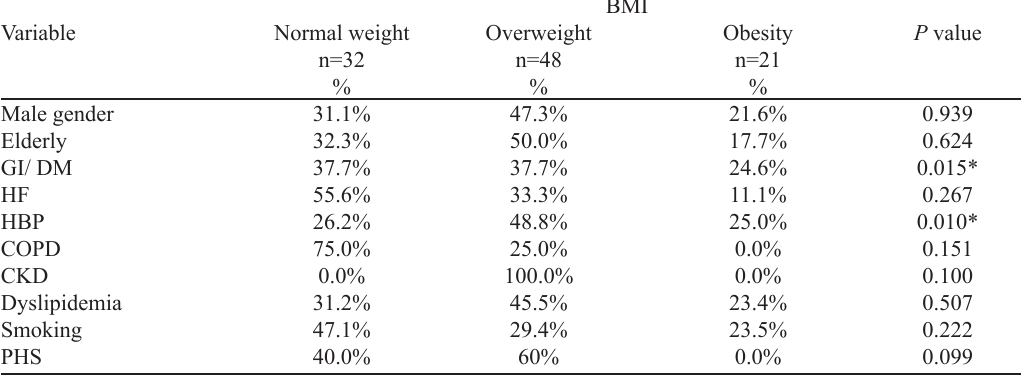
Table 2. Demographic characteristics, comorbidities, and risk factors during preoperative evaluation of patients undergoing heart